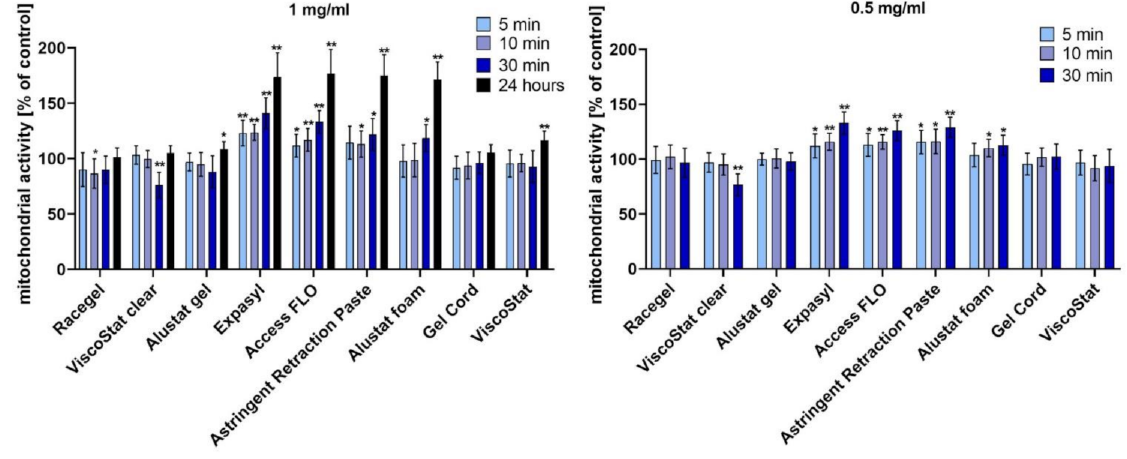
Figure 1. The viability evaluated by MTT assay in human gingival fibroblasts after various time points of incubation (5, 10, and 30 min, and 24 h), with the gingival retraction agents diluted in the cell culture medium to 1 mg/mL and 0.5 mg/mL concentrations; * p < 0.05, ** p <